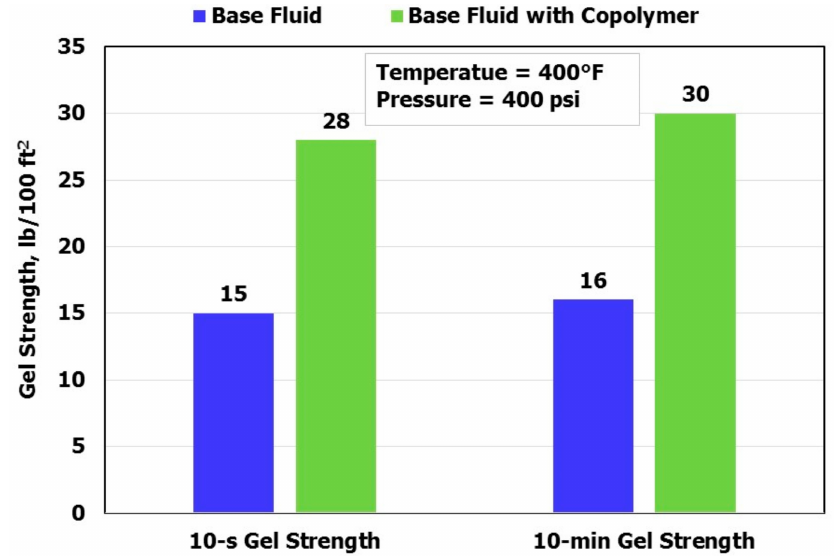
Figure 10. Effect of temperature of the gel